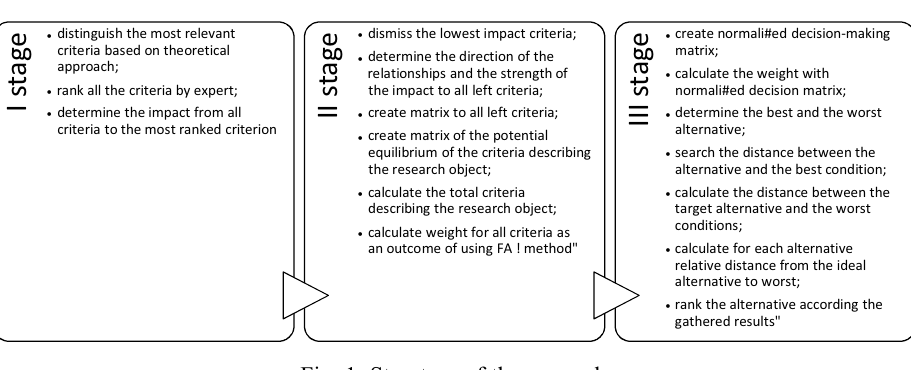
Fig. 1. Structure of the